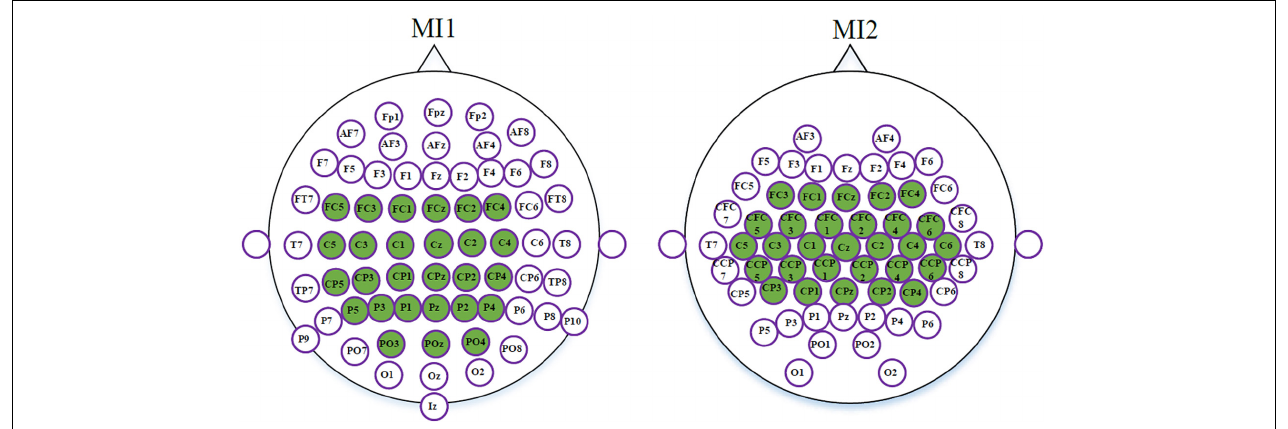
FIGURE 3 | The selected channels for MI1 and